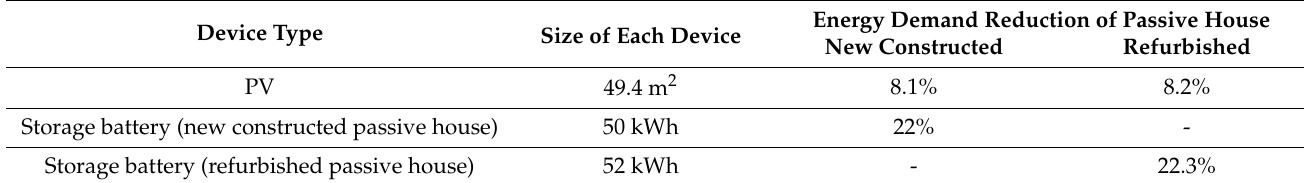
Table 11. Energy demand reduction ratio of applying renewable energy